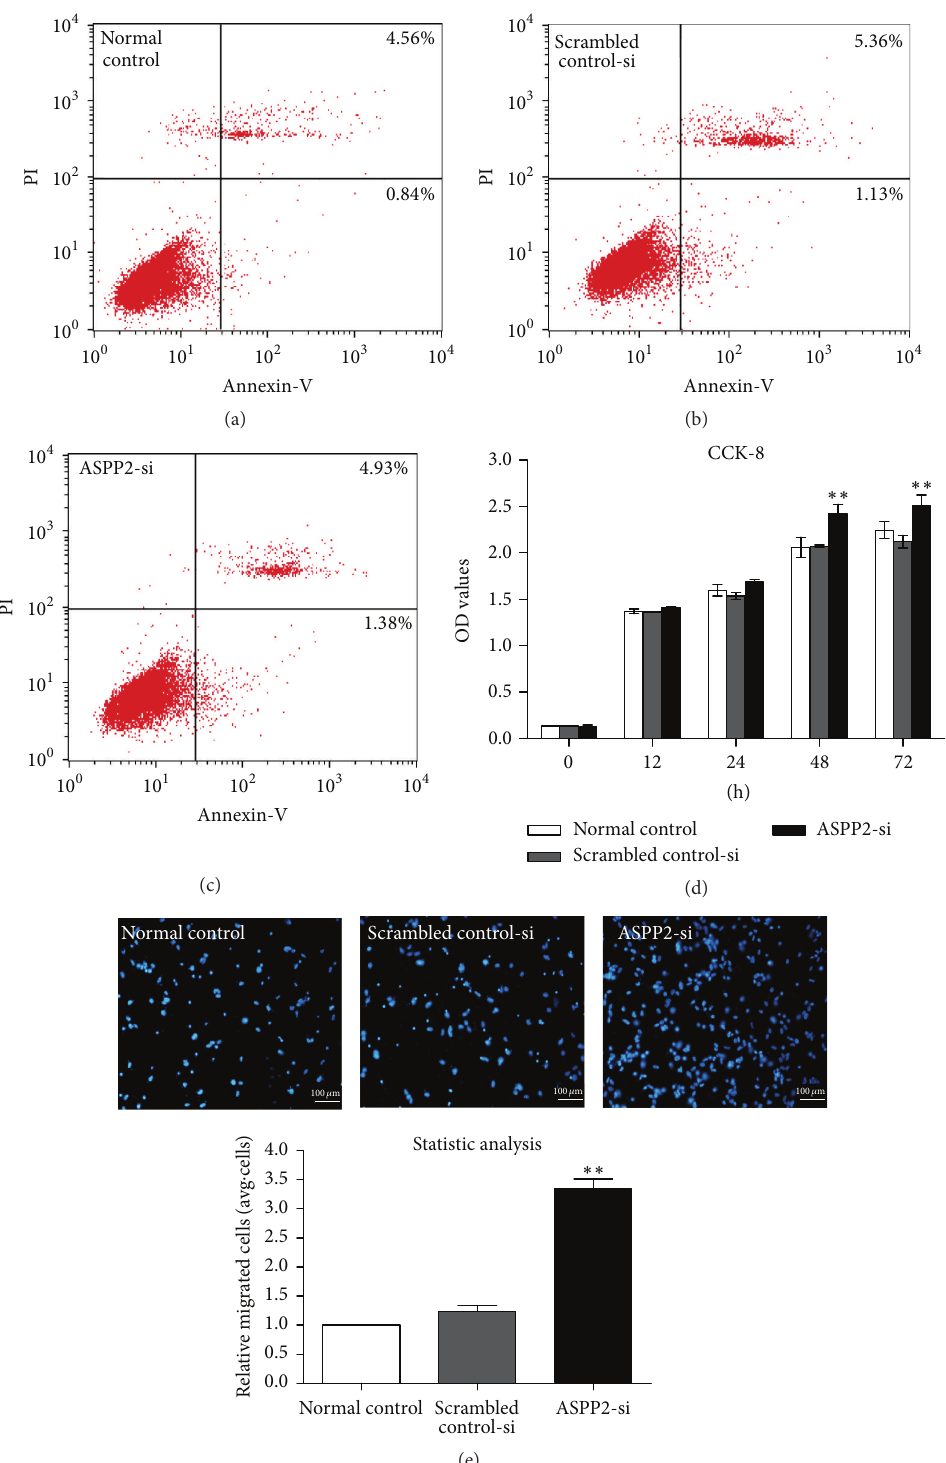
Figure 3: Cytotoxicity, proliferation, and migration induced by transfection of ARPE-19 cells. Normal control ARPE-19 cells without treatment and cells transfected with scrambled control-siRNA or ASPP2-siRNA were incubated for 48 h. Then, cells were stained with Annexin V and propidium iodide, followed by flow cytometry measurement. Rates of early apoptotic cells and late apoptotic cells are shown in the bottom right and top right quadrants, respectively (a, b, and c). Representative results of three independent experiments are shown. Cell proliferation was measured with a CCK-8 assay at 0, 12, 24, 48, and 72h (d). Cell migratory activity was determined by Transwell assay 48 h after transfection (e). Statistical analysis based on the number of cells that had migrated through the filter of the chamber, showing that ASPP2 knockdown promoted cell migration significantly. Data are shown as the mean ± SD, 𝑛 = 4 experiments. ∗∗ 𝑃 < 0.01 versus normal control or Scrambled control-siRNA